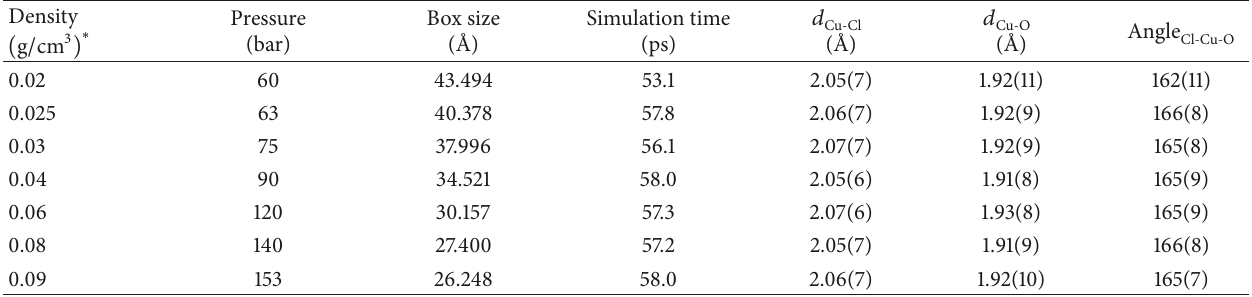
Table 1: Simulation details for a model at 350 ∘ C with 1 Cu, 1 Cl, and 55 H 2 O in the box, and the geometry of the first-shell CuCl(H 2 O)